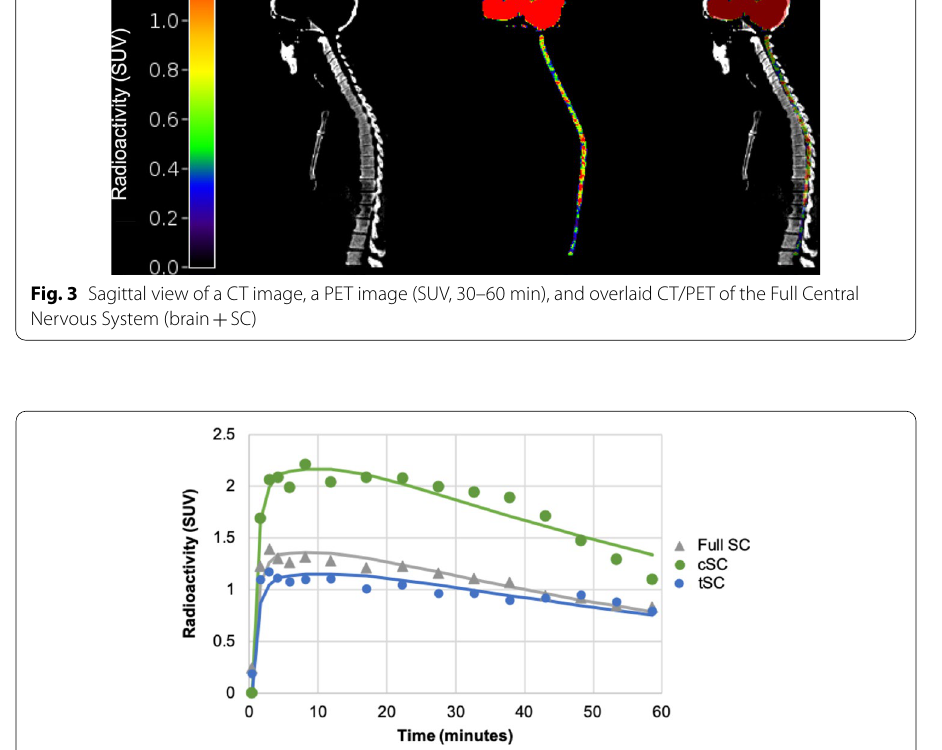
Fig. 4 Example full Spinal Cord (SC), cervical spinal cord (cSC), and thoracic spinal cord (tSC) time activity curves with SRTM2 fit (solid line)